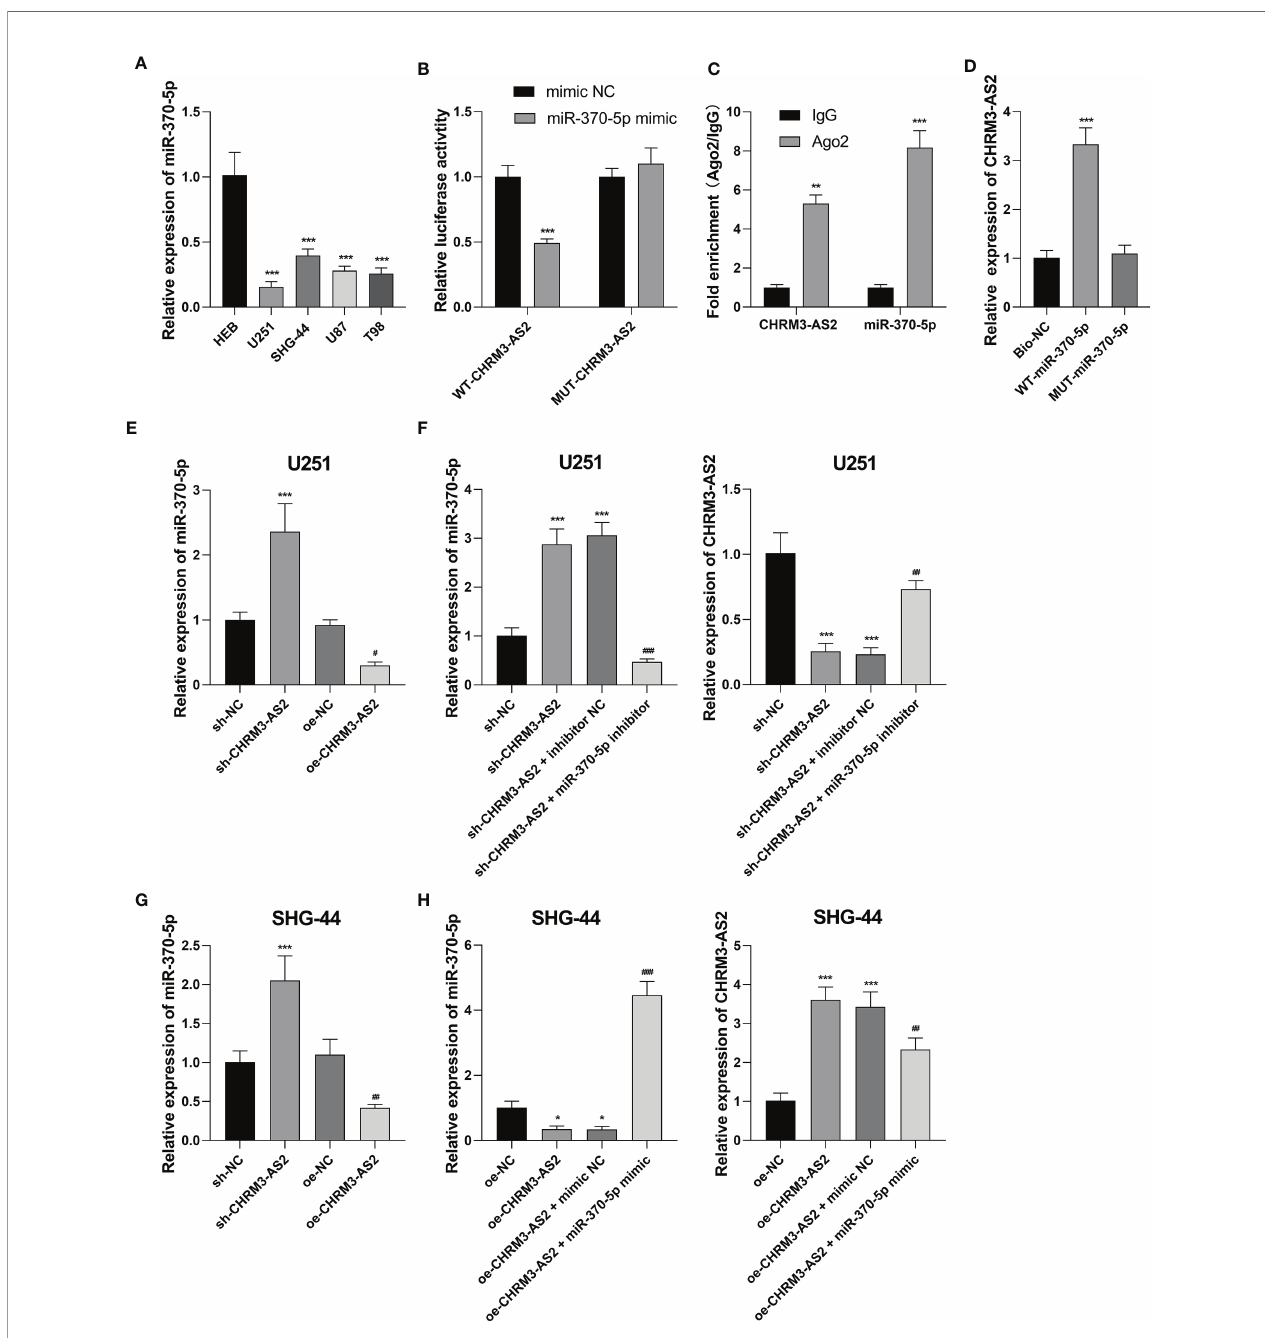
FIGURE 4 | CHRM3-AS2 targeted miR-370-5p in glioma cells. (A) The expression of miR-370-5p in a normal human glial cell line (HEB) and four glioma cell lines (U251, SHG-44, U87, and T98) was quanti fi ed via qRT-PCR; ***P < 0.001 vs. HEB. (B) The relationship between CHRM3-AS2 and miR-370-5p was determined via DLR assays; ***P < 0.001 vs. mimic NC. (C) The relationship between CHRM3-AS2 and miR-370-5p was determined via RIP assays; **P < 0.01, ***P < 0.001 vs. IgG. (D) The relationship between CHRM3-AS2 and miR-370-5p was determined via RNA pull-down assays; ***P < 0.001 vs. Bio-NC. (E) Expression of miR-370-5p in U251 cells transfected with sh-CHRM3-AS2/sh-NC or oe-CHRM3-AS2/oe-NC was quanti fi ed via qRT-PCR; ***P < 0.001 vs. sh-NC; # P < 0.05 vs. oe-NC. (F) Expression of miR-370-5p and CHRM3-AS2 in U251 cells transfected with sh-CHRM3-AS2/sh-NC and miR-370-5p inhibitor/inhibitor NC was quanti fi ed via qRT- PCR; ***P < 0.001 vs. sh-NC; ## P < 0.01, ### P < 0.001 vs. sh-CHRM3-AS2. (G) Expression of miR-370-5p in SHG-44 cells transfected with sh-CHRM3-AS2/sh-NC or oe-CHRM3-AS2/oe-NC was quanti fi ed via qRT-PCR; ***P < 0.001 vs. sh-NC; ## P < 0.01 vs. oe-NC. (H) Expression of miR-370-5p and CHRM3-AS2 in SHG-44 cells transfected with oe-CHRM3-AS2/oe-NC and miR-370-5p mimic/mimic NC was quanti fi ed via qRT-PCR; *P < 0.05, ***P < 0.001 vs. oe-NC; # P < 0.05, ## P < 0.01, ### P < 0.001 vs.